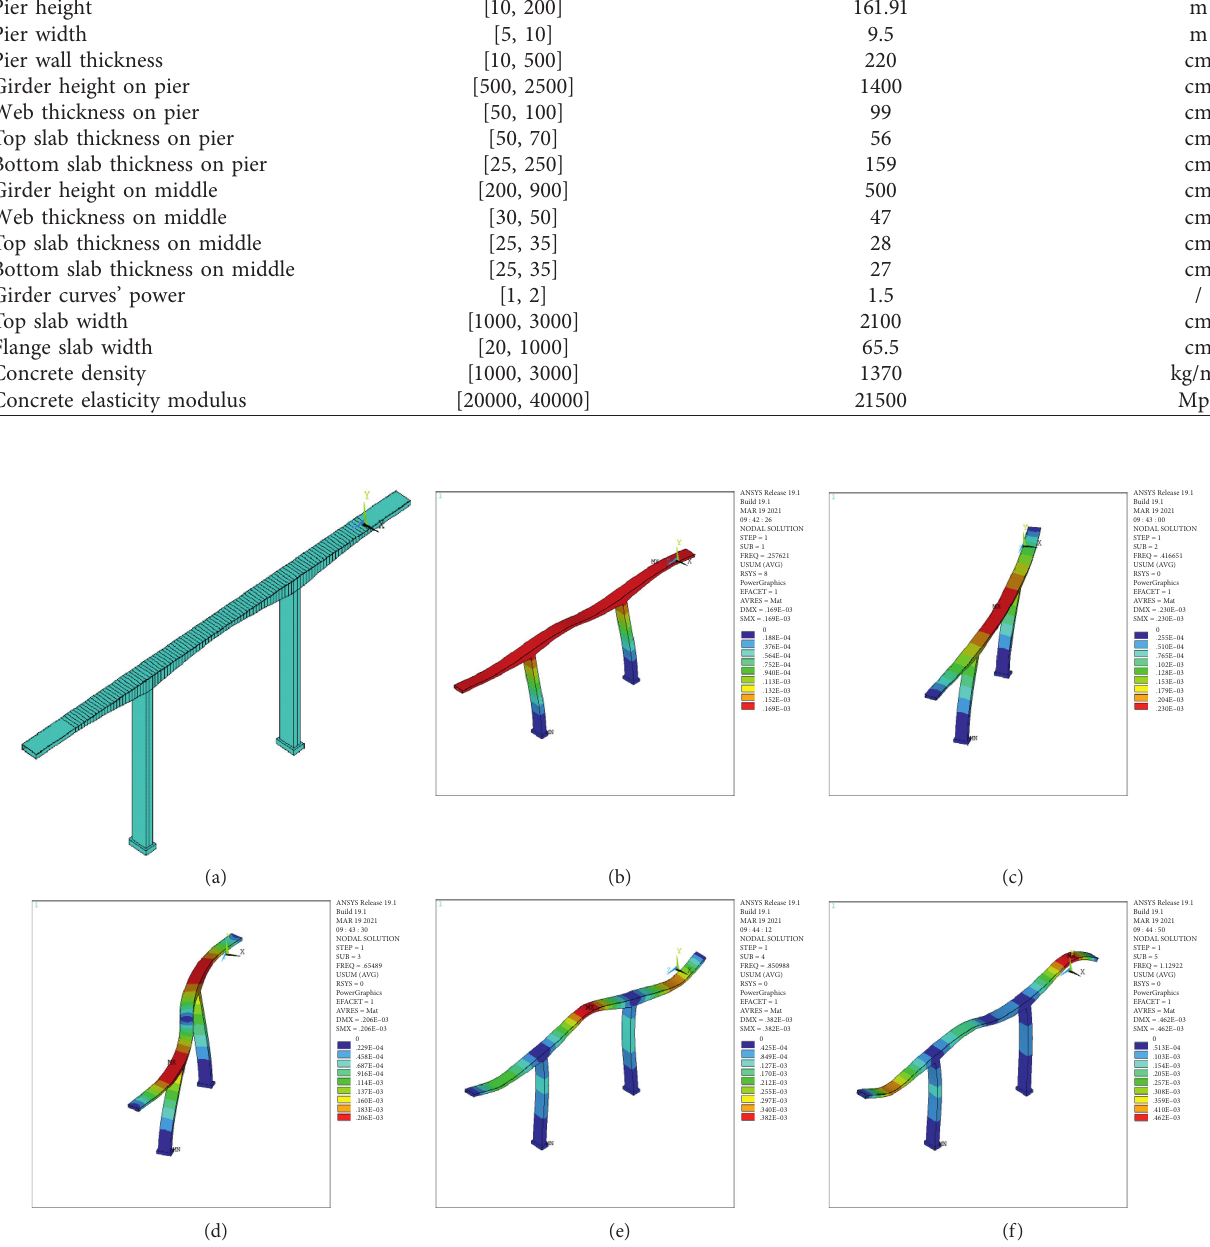
Figure 5: Finite element model and frequency result. (a) Finite element model. (b) First-order mode shape ( f � 0.258Hz). (c) Second-order mode shape ( f � 0.417Hz). (d) Third-order mode shape ( f � 0.655Hz). (e) Fourth-order mode shape ( f � 0.851 Hz). (f) Fifth-order mode shape ( f � 1.129Hz).